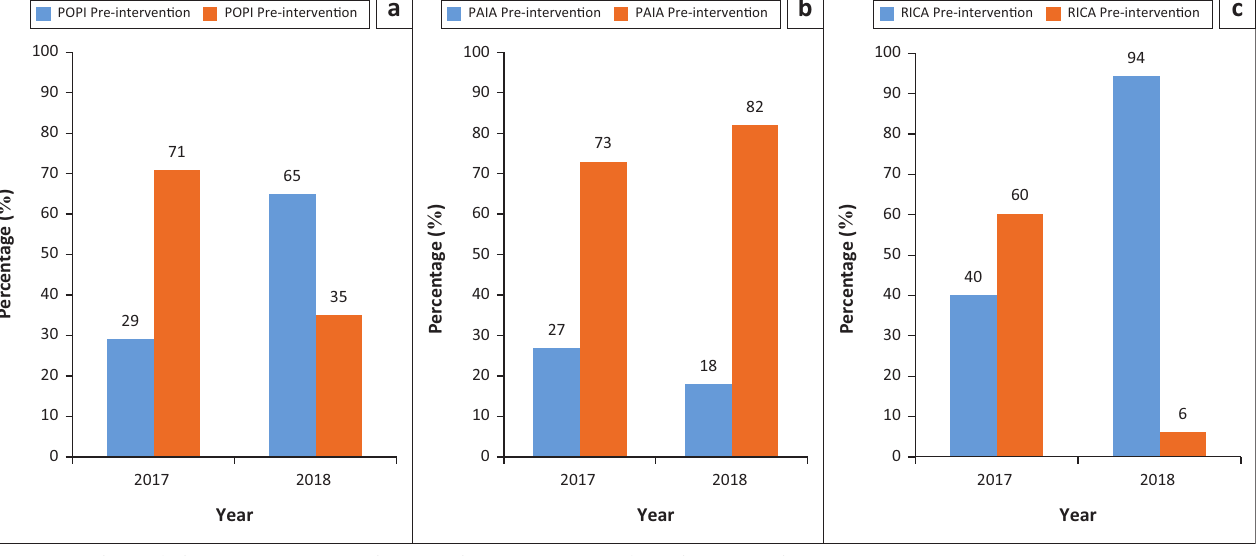
FIGURE 6: Pre-intervention application knowledge of Protection of Personal Information, Promotion of Access to Information Act and Regulation of Interception of Communication Act for the years 2017 and 2018.